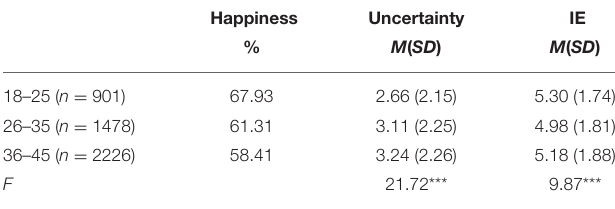
TABLE 6 | Comparison of variable scores of different age